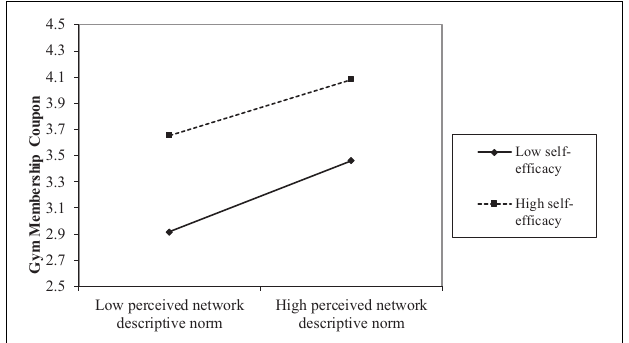
FIGURE 3 | Self-efficacy moderated the relationship between perceived descriptive norm of workout and the intention to purchase the coupon for gym membership.